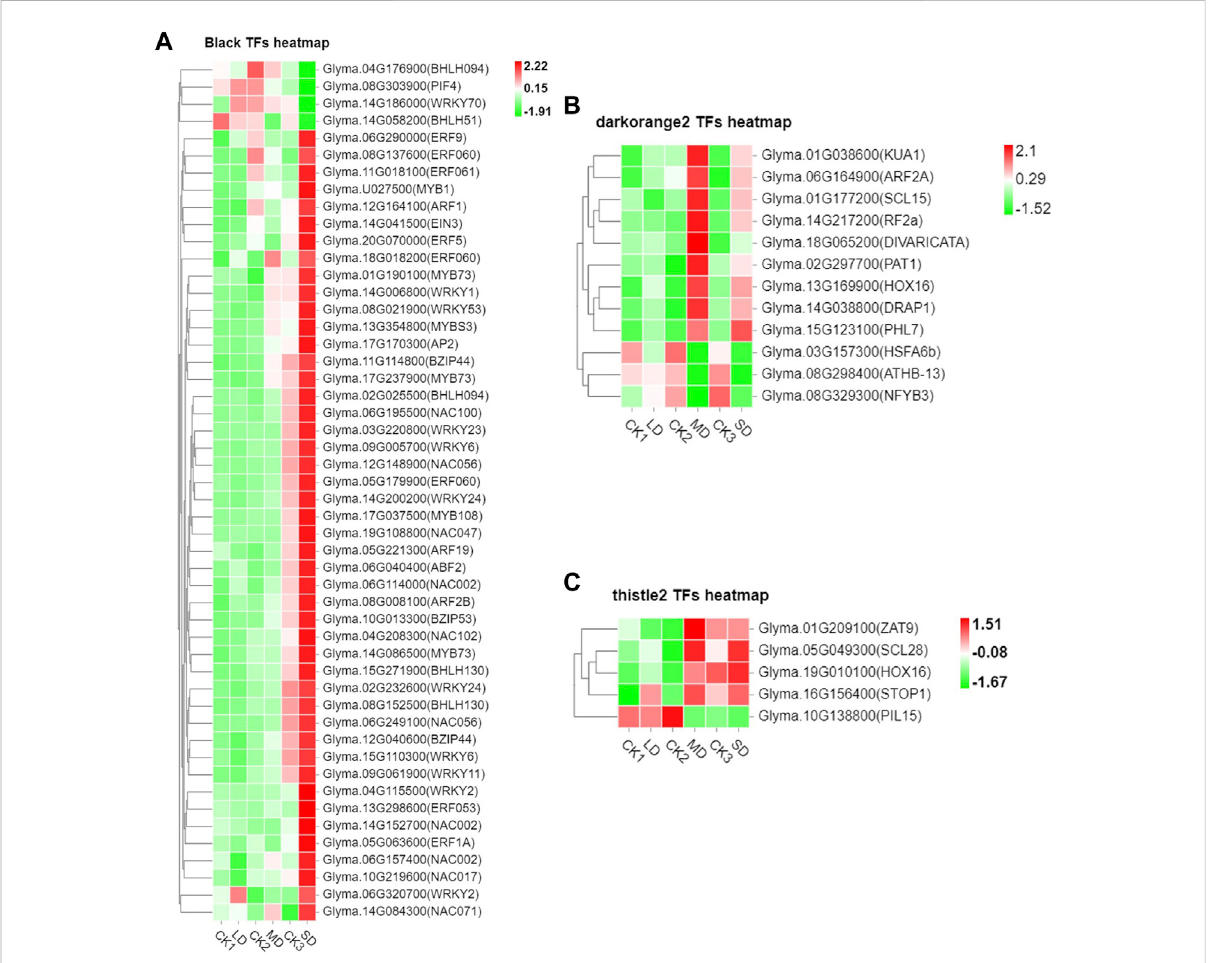
FIGURE 4 Heatmap of drought-induced TFs in three modules under drought stress. (A) Fifty drought-induced TFs in Black module. (B) Twelve drought- induced TFs in the Darkorange2 module. (C) Five drought-induced TFs in the Thistle2 module. The colors of the heatmap vary from green to red by normalizing the log 2 (FPKM) of each